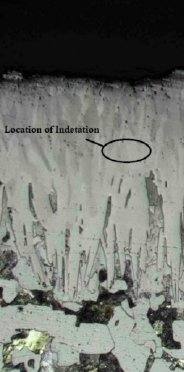
Figure 14. Location of the area where the micro-indentation hardness test was conducted for the boronized low carbon steel.